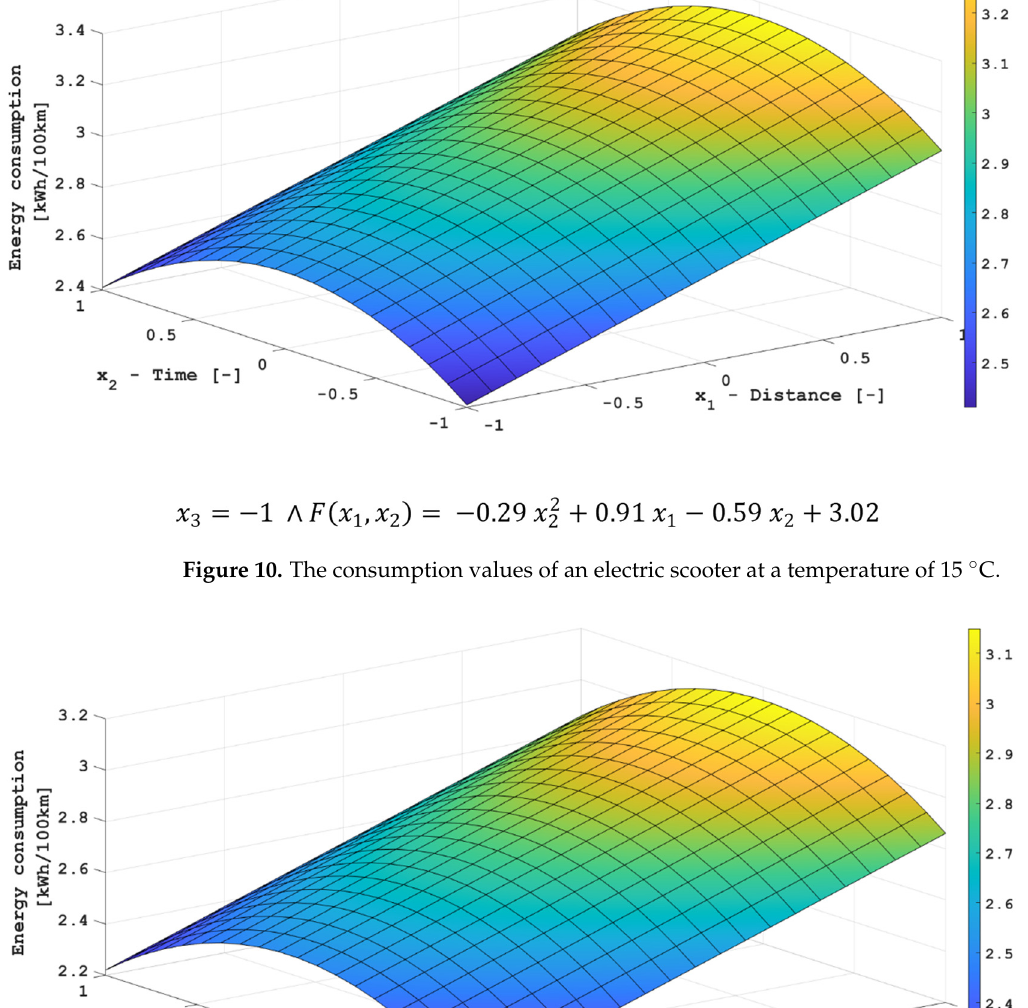
Figure 11. The values of consumption of an electric scooter at a temperature of 20 °C.